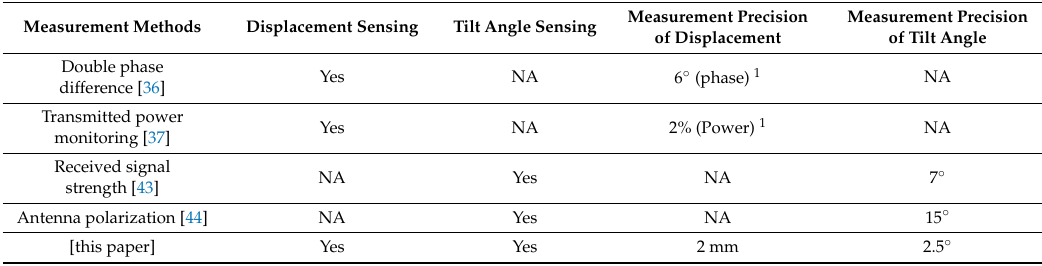
Table 1. Comparison of sensing capability and measurement